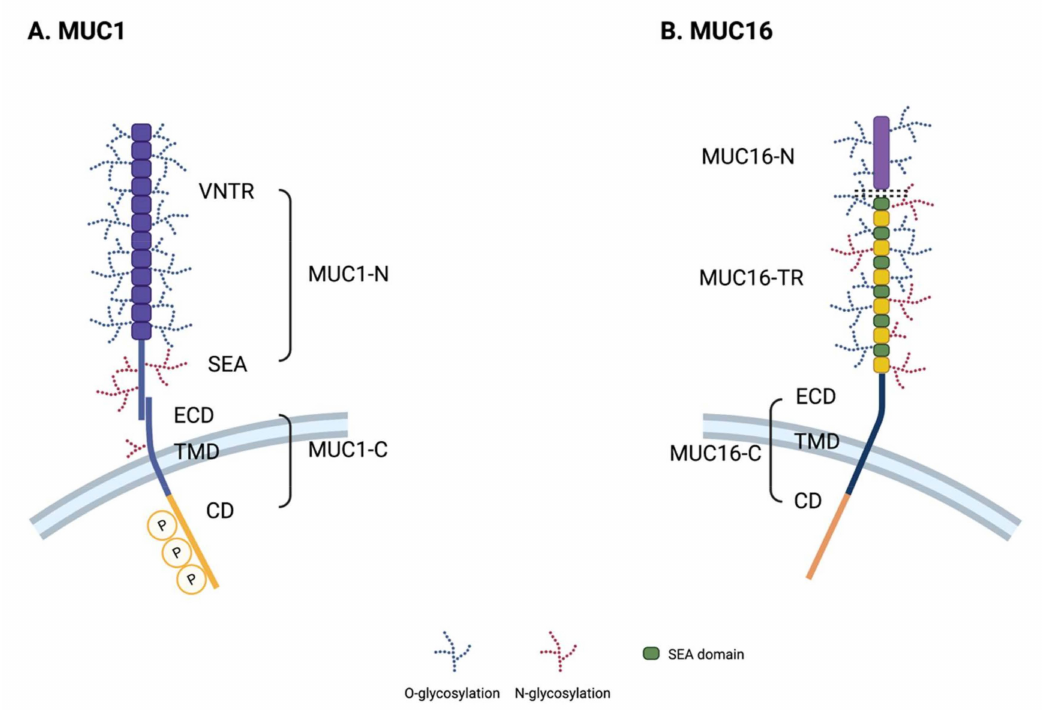
Figure 1. Schematic representation of the MUC1 and MUC16 structures. ( A ) MUC1 is a stable heterodimeric complex with an N-terminal subunit (MUC1-N) and C-terminal subunit (MUC1-C). The variable number tandem repeat (VNTR) region in MUC1-N is composed of a 20 amino acid repeat sequence that is extensively O -glycosylated at the serine and threonine residues. SEA domain is auto-cleaved and non-covalently linked to the extracellular domain (ECD) of the MUC1-C subunit. MUC1-C is anchored in the plasma membrane of cells via its transmembrane domain (TMD). The cytoplasmic domain (CD) of MUC1 contains potential binding motifs for various signaling proteins with phosphorylation sites. ( B ) MUC16 is a single transmembrane glycoprotein consisting of a large N-terminal domain (MUC16-N) and tandem repeat domain (MUC16-TR) that is interspersed with an SEA domain and C-terminal domain